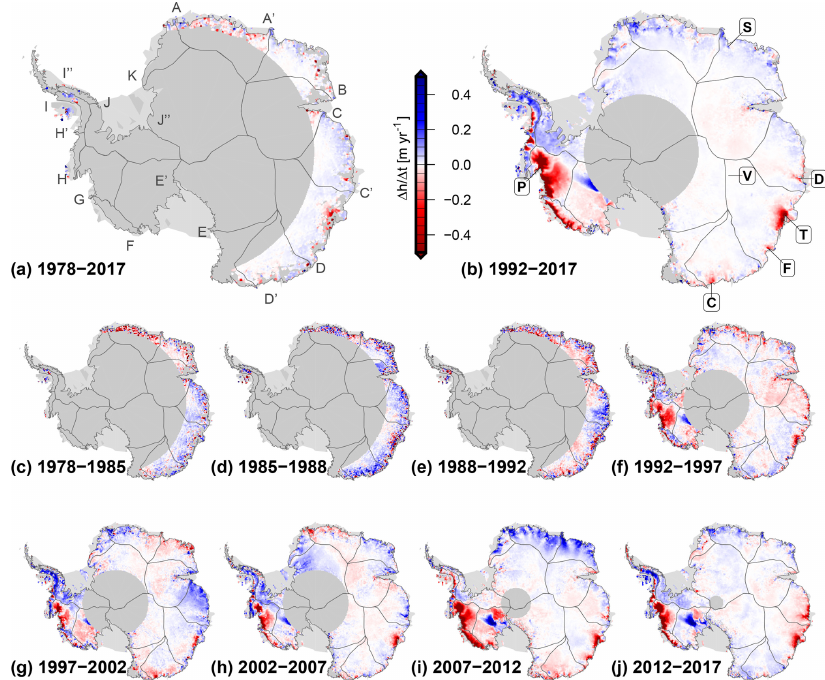
Figure 9. Multi-mission surface elevation change from the combined SEC time series over different time intervals. (a, b) The long-term surface elevation change between 1978 and 2017 and 1992 and 2017 for the covered area. (c–j) Elevation change over consecutive time intervals reveals the interannual variability. Thin lines mark the drainage basin outlines, denoted in panel (a) . Bold letters in boxes in panel (b) denote areas mentioned in the text and in Fig.